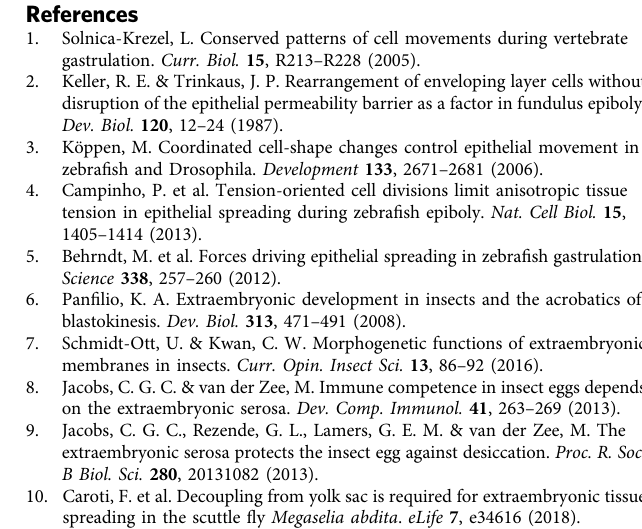
Fig. 5 Cell and tissue dynamics in Tc-zen1 knock-down embryos. a Maximum intensity projections of a parental Tc-zen1 RNAi embryo labeled with LifeAct- eGFP and imaged with confocal microscopy. Arrows point to the open serosa window in the head and the posterior region. Time stamps are hh:mm. Scale bar is 50 µ m. N = 1 (2 datasets available). b Selected maximum intensity projection images from wild-type (top) and parental Tc-zen1 RNAi (bottom) embryos at Stage 3. Insets show the cable in wild-type embryos (arrow) and absence of the cable in the knock-down (*). Scale bars are 50 µ m. Wild type N = 1, Tc-zen1 RNAi N = 1. c Distribution of apical cell areas in wild-type (left) and embryonic Tc-zen1 RNAi (right) embryos sampled from confocal datasets in the dorsal serosa at Stage 3. The number of cells ( n ) and embryos ( N ) sampled are n = 39 and N = 6 wild-type embryos and n = 55 and N = 7 Tc-zen1 RNAi embryos. d Distribution of apical cell areas in wild-type (left) and embryonic Tc-zen1 RNAi (right) embryos sampled from confocal datasets in the ventral serosa at Stage 3. The number of embryos ( N ) and cells ( n ) sampled are n = 52 and N = 7 in wild-type and n = 38 and N = 7 in Tc-zen1 RNAi embryos. e Cartographic projections of embryonic Tc-zen1 RNAi embryo injected with Gap43-eYFP mRNA reconstructed from a multi-view SPIM recording. Time stamps are hh:mm. Scale bar is approximately 100 µ m. N = 1. f Cartographic projections shown in e overlaid with outlines of serosal cells. Serosal cell in each projection were segmented automatically, curated manually, and color coded according to their apical cell area. N = 1. g Segmented cartographic projections as in f color coded according to the shape index of the segmented serosal cells. h Distribution of shape indices in wild-type and Tc-zen1 RNAi embryos sampled from confocal datasets in the dorsal serosa at Stage 3. Numbers of cells and embryos are the same as in c . i Distribution of shape indices in wild-type and Tc-zen1 RNAi embryos sampled from confocal datasets in the ventral serosa at Stage 3. Numbers of cells and embryos are the same as in d . j Segmented cartographic projections as in f , g color coded according to the tissue fl uidity values of the segmented serosal cells (see “ Methods ” section